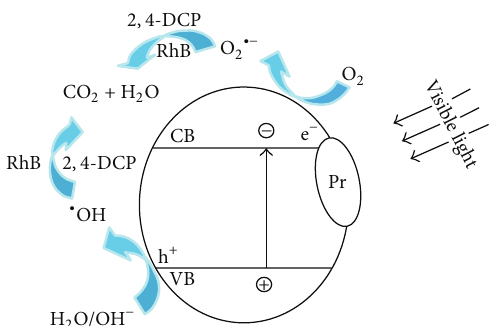
Figure 9: Photocatalysis process of Pr-doped BSO photocatalyst under visible light